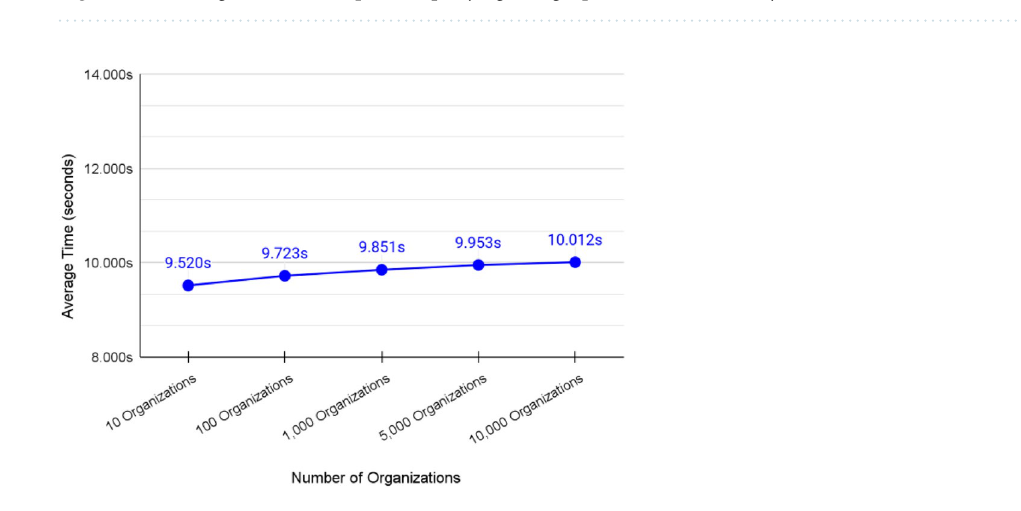
Figure 13. Average transaction speed of querying a single patient from authority shard.